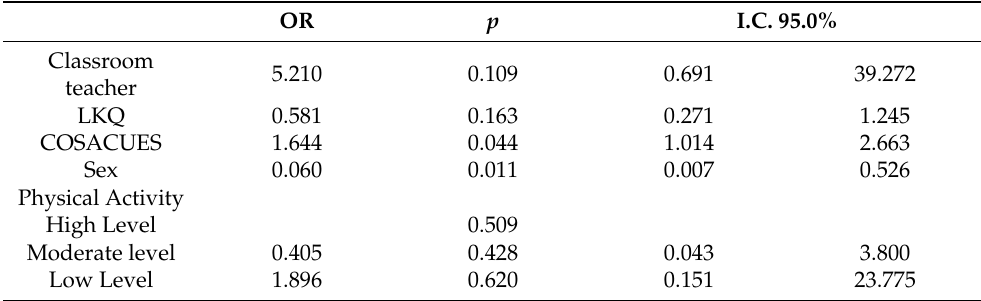
Table 3. Logistic regression results for determining LBP